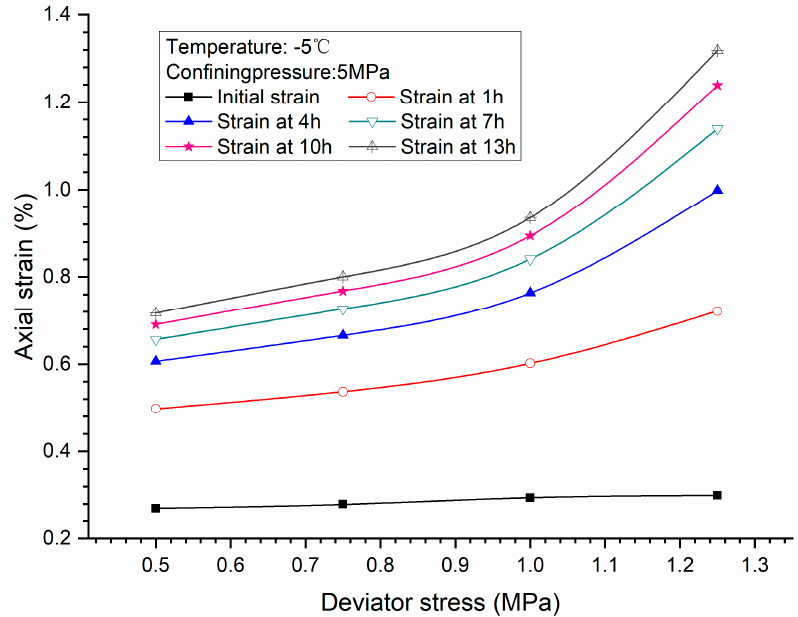
Figure 5. Initial strain and axial strains versus deviator stress for methane hydrate-bearing frozen specimens under low deviator stresses.